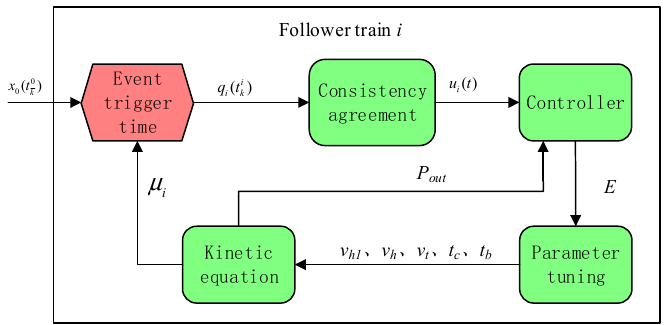
Figure 1. Control structure diagram of follower train.